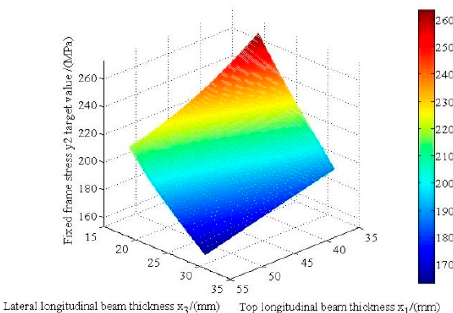
Figure 15. Three-dimensional response model with x 1 and x 3 .